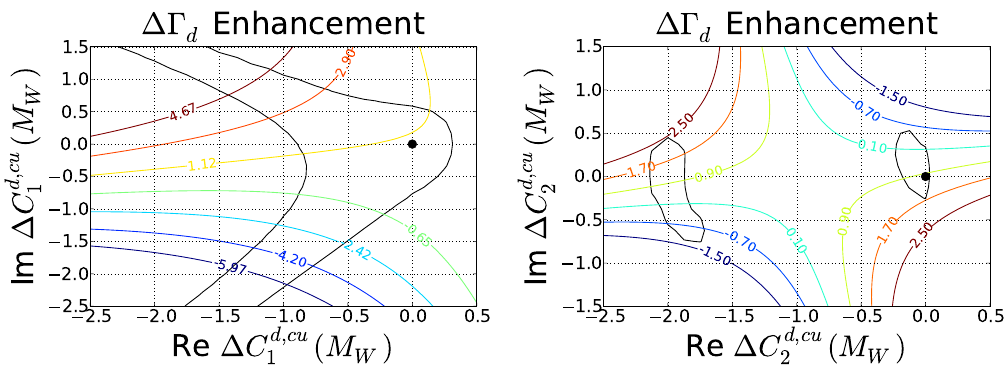
Figure 19 . Global (cid:31) 2 -(cid:12)t including observables constraining the inclusive transition b ! c (cid:22) ud . The 90% C.L. allowed regions correspond to the areas contained within the black contours. The colored curves indicate the possible enhancements on (cid:1)(cid:0) d with respect to the SM value. The black dot corresponds to the SM